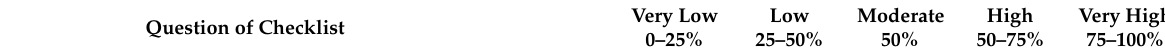
Table 4. The developed checklist to measure client satisfaction in the build